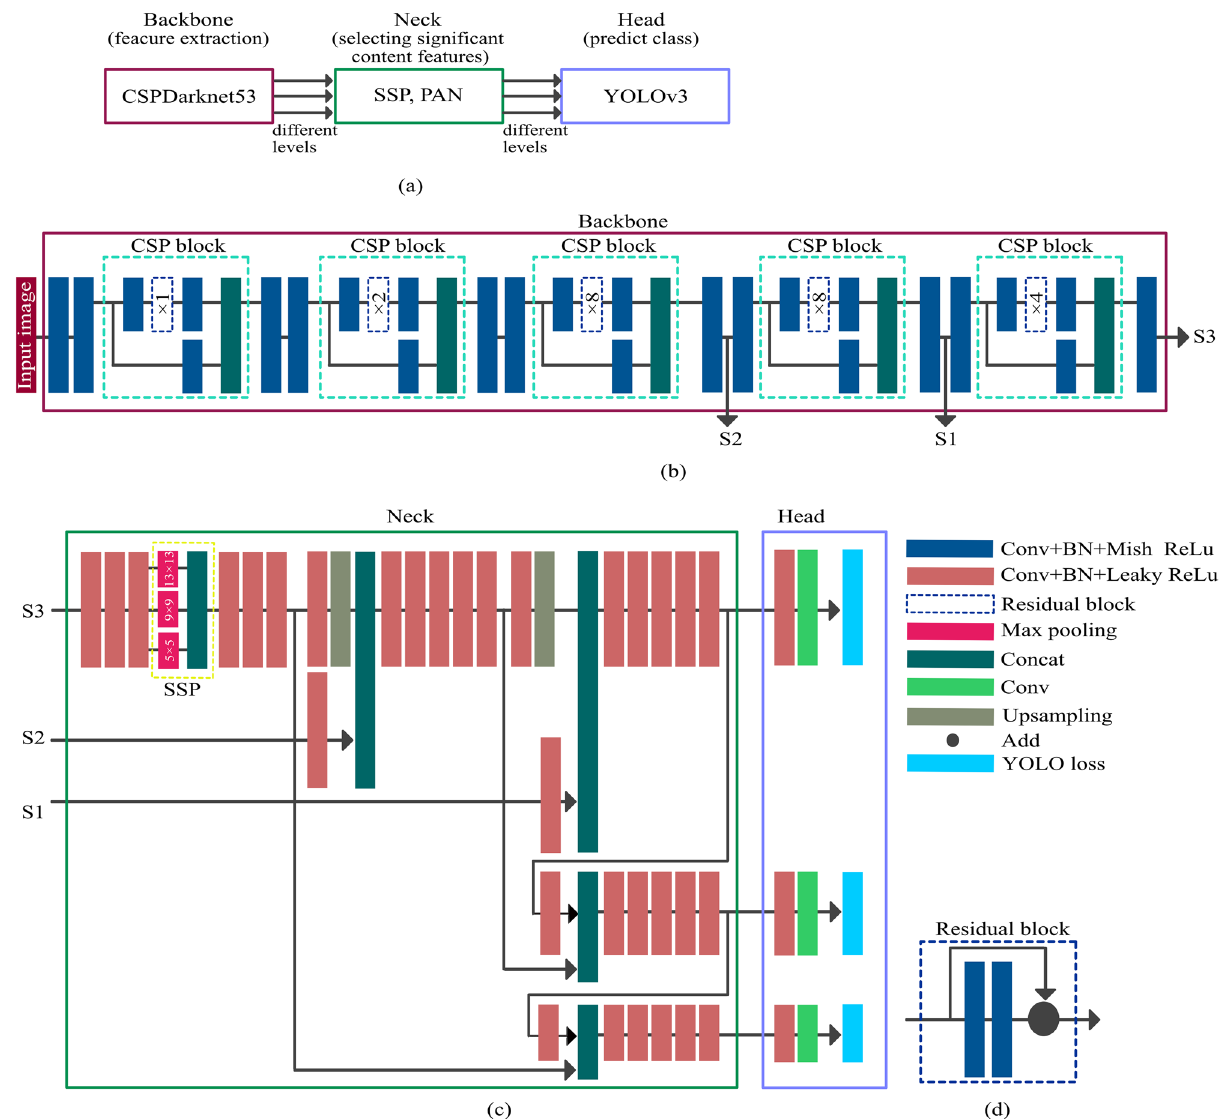
Figure 5. ( a ) Deep neural network structures, which are composed of three major parts (Backbone, Neck, and Head). ( b ) Network structures for Backbone, which contains 52 convolutional layers with CSP block to reduce dimensions. The number of repetitions for the residual block is in the blue dotted rectangle. ( c ) Network structures for Neck and Head. Input data (S1, S2, and S3) is from the Backbone (S1, S2, and S3). ( d ) The residual block, which applies shortcut connections to involve two sets of convolutional (Conv), batch normalization (BN) and ReLU layers. Abbreviations: CSP = Cross stage partial, SSP = Spatial pyramid pooling, PAN = Path aggregation network, ReLU = Rectified linear units, YOLO = you only look